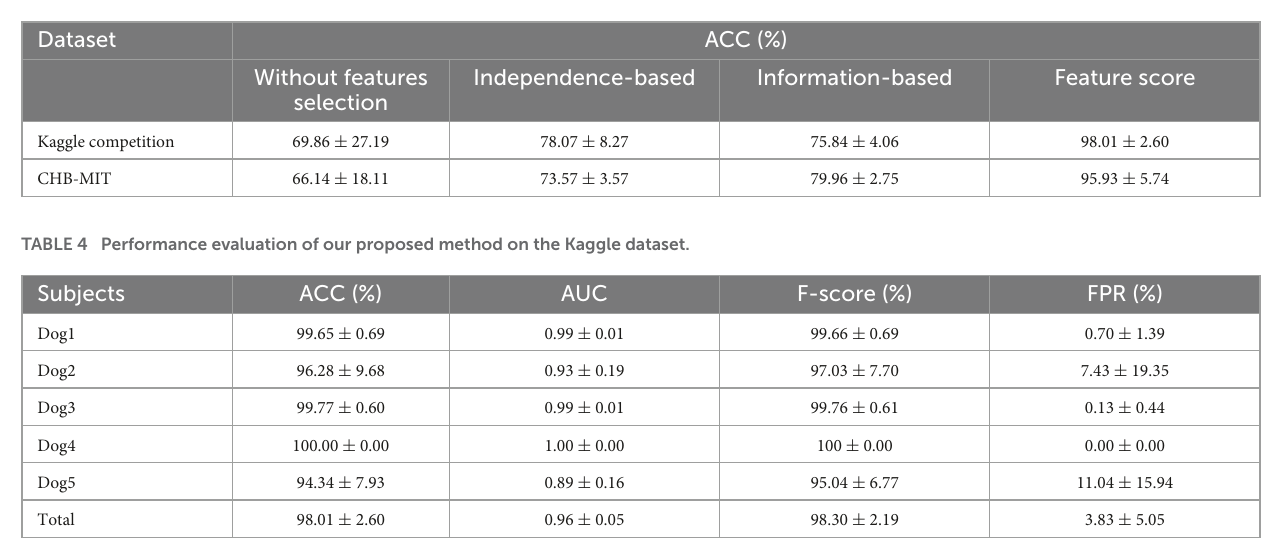
TABLE 3 Comparison of four feature selection schemes.